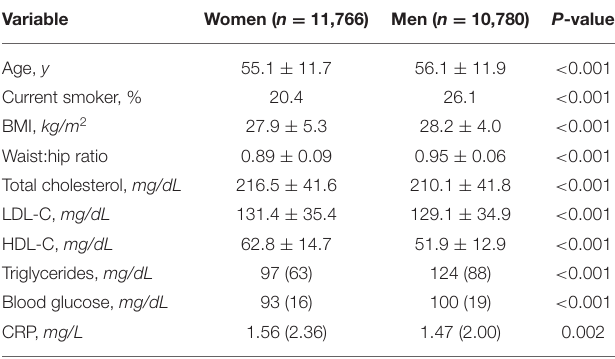
TABLE 2 | Thrombin generation (TG) parameters in the Moli-sani cohort, stratified by